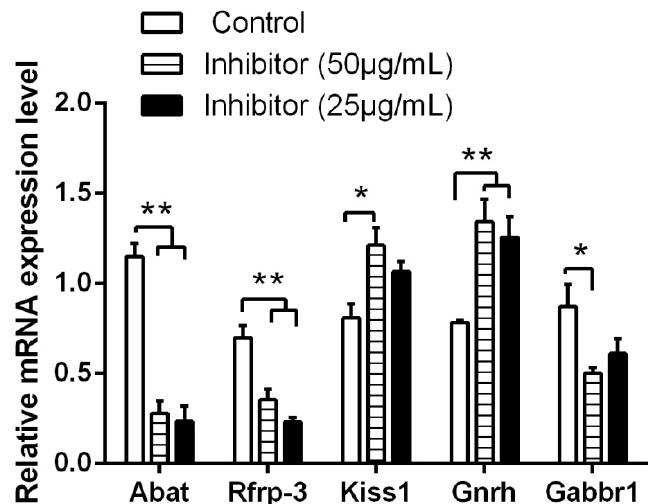
Figure 2. E ff ects of GABA-T inhibitors on the expression of reproduction-related genes in hypothalamic neurons. ** indicates a very significant di ff erence ( p < 0.01); * indicates a significant di ff erence ( p < 0.05). Figure 2. Effects of GABA-T inhibitors on the expression of reproduction-related genes in Vigabatrin was used as a GABA-T hypothalamic neurons. ** indicates a very significant difference ( p < 0.01); * indicates a significant difference ( p < 0.05). Vigabatrin was used as a GABA-T inhibitor.